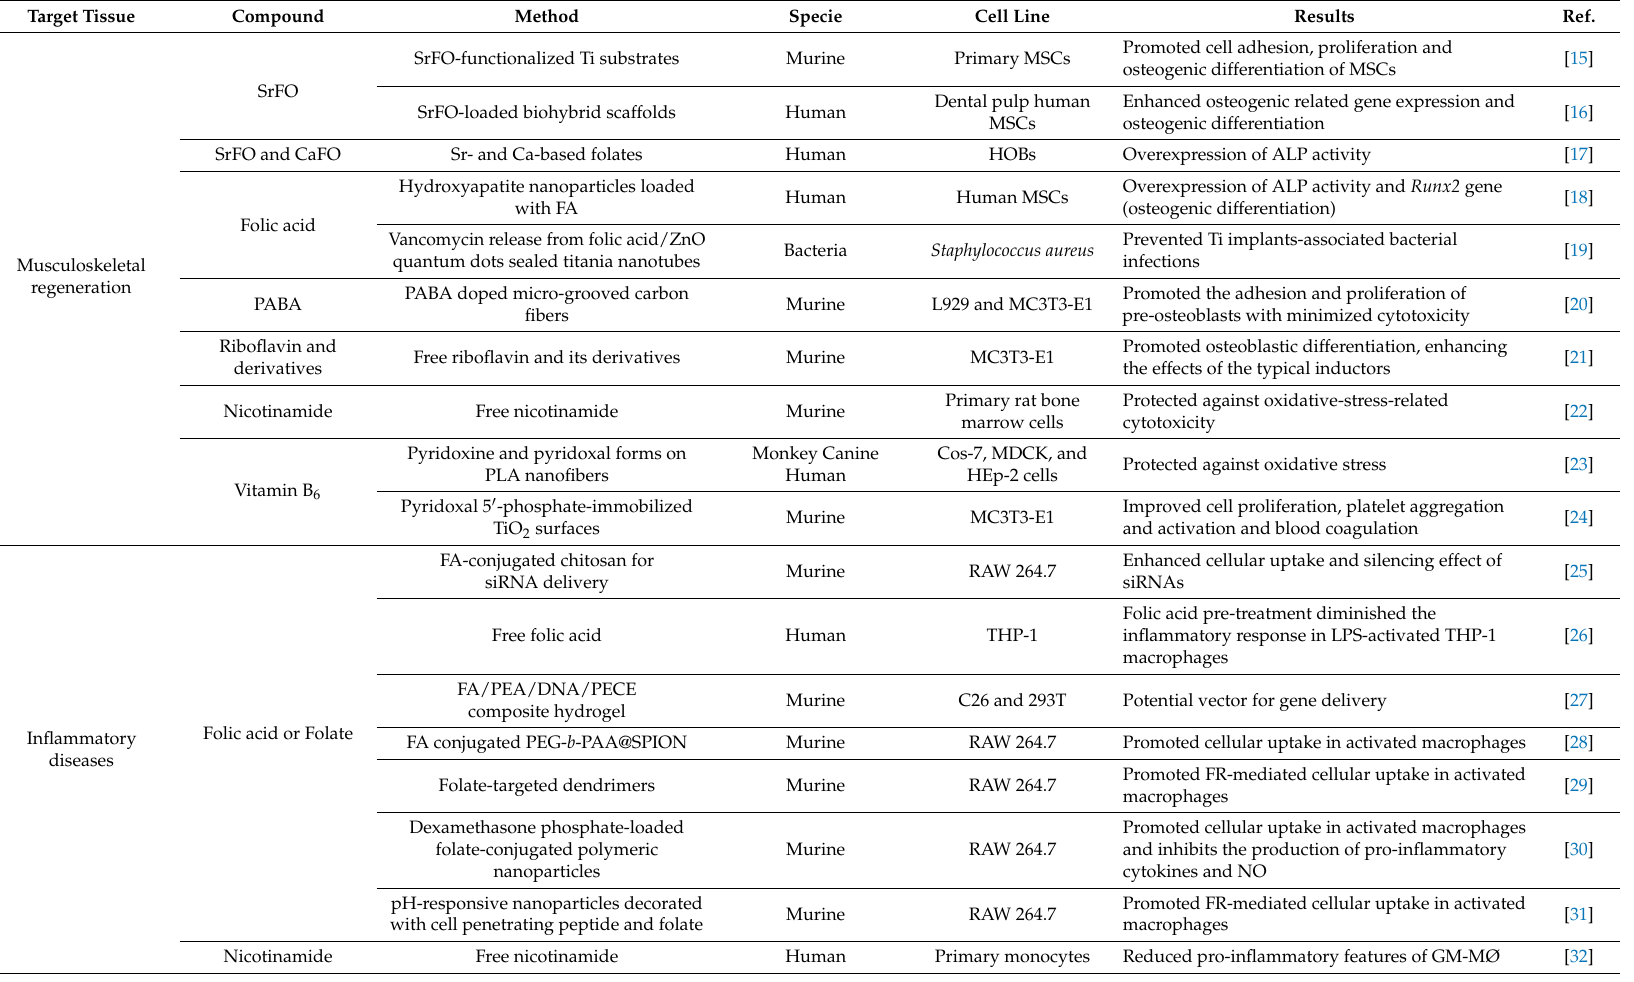
Table 1. In vitro studies using B-vitamins-based regenerative